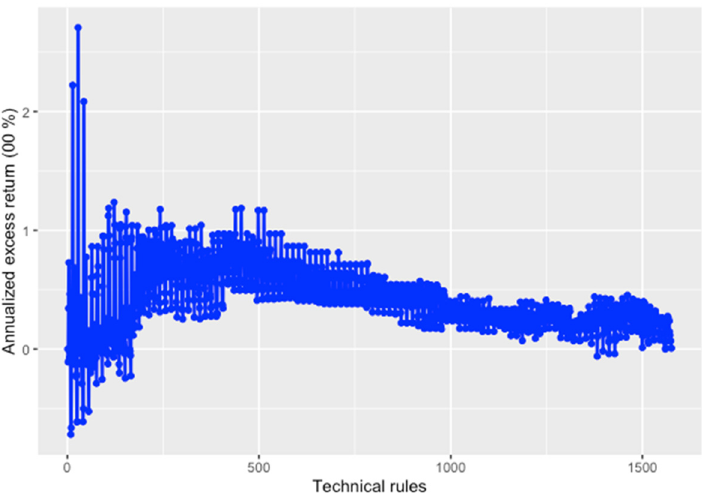
Figure 6. Excess returns* net of transaction costs of 5 bps for all 1575 SMA cross-over rules for the